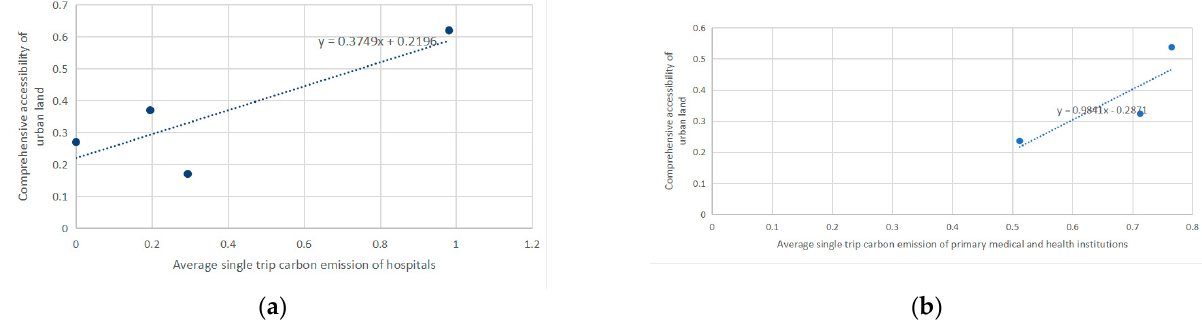
Figure 11. ( a ) Correlation between average single trip carbon emissions of hospitals and comprehensive accessibility, ( b ) Corre- lation between average single trip carbon emissions of primary medical and health institutions and comprehensive accessibility.